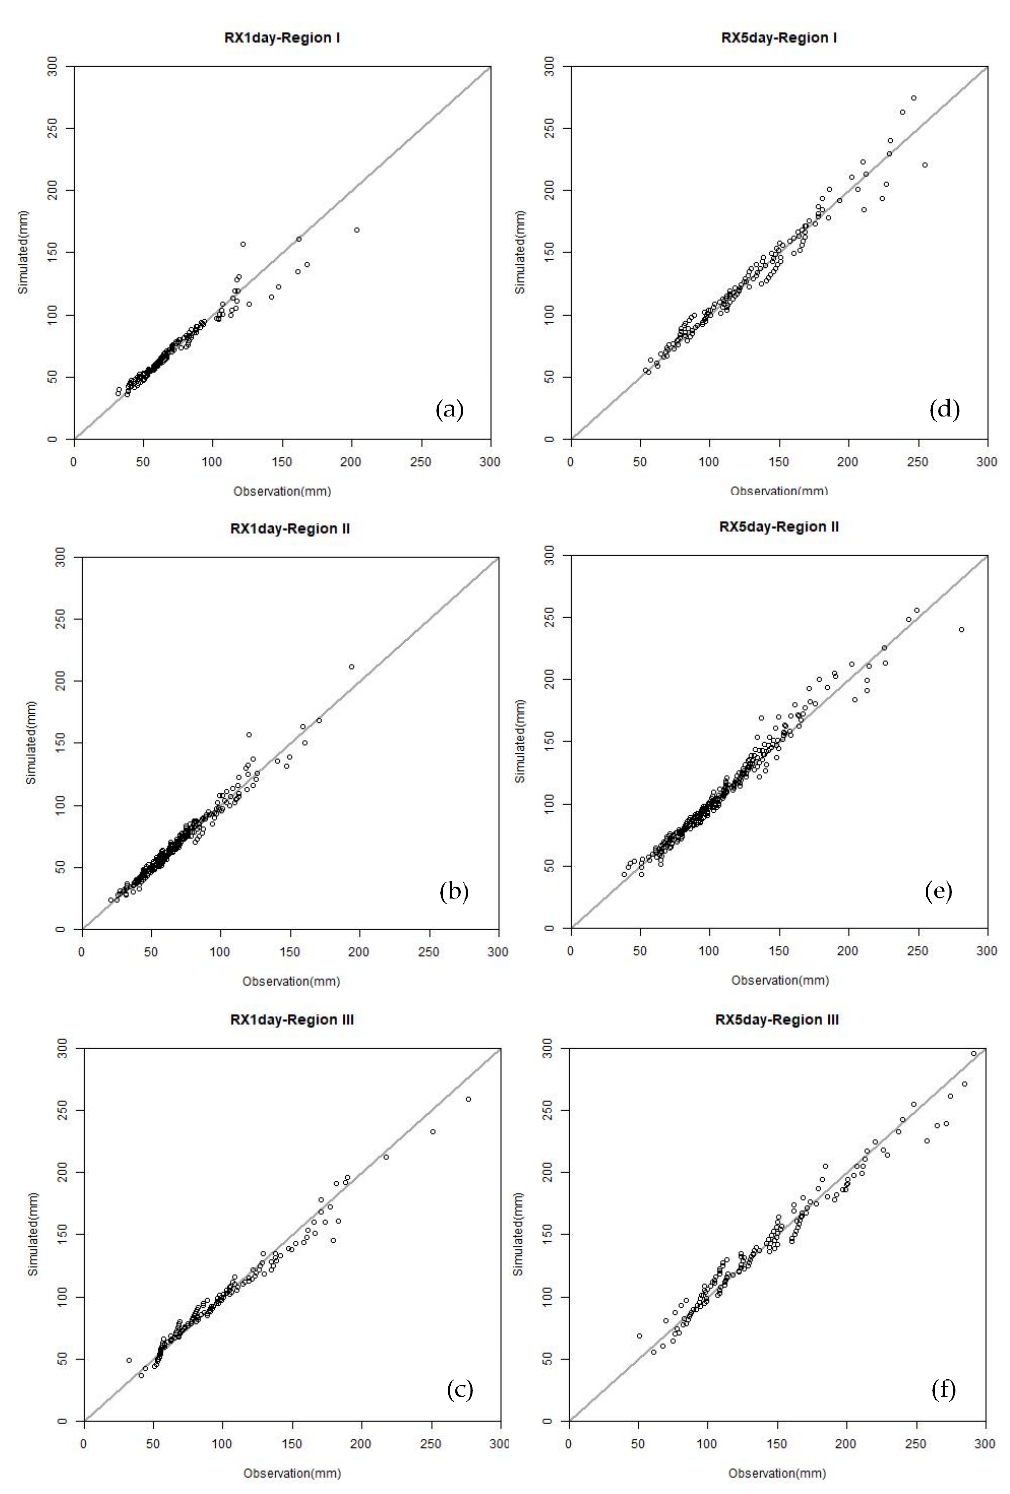
Figure 5. Observation and simulation value of precipitation extremes in each region of RX1day ( a , b , c ) and RX5day ( d , e , f ) series.